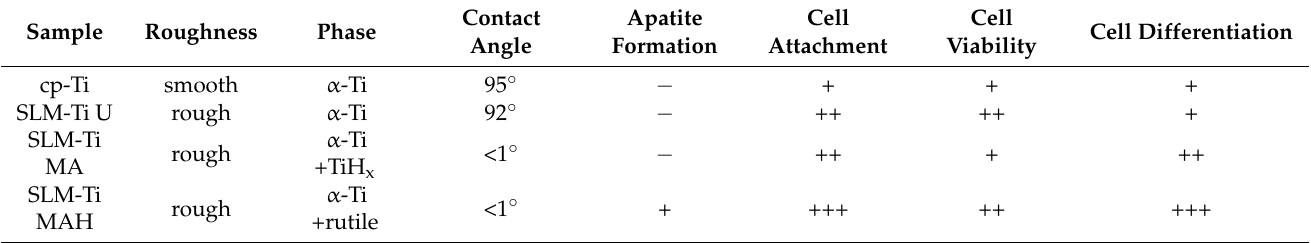
Table 2. Surface characteristics, apatite formation, and cell responses of cp-Ti and SLM-Ti with or without mixed acid and heat treatment. Sample